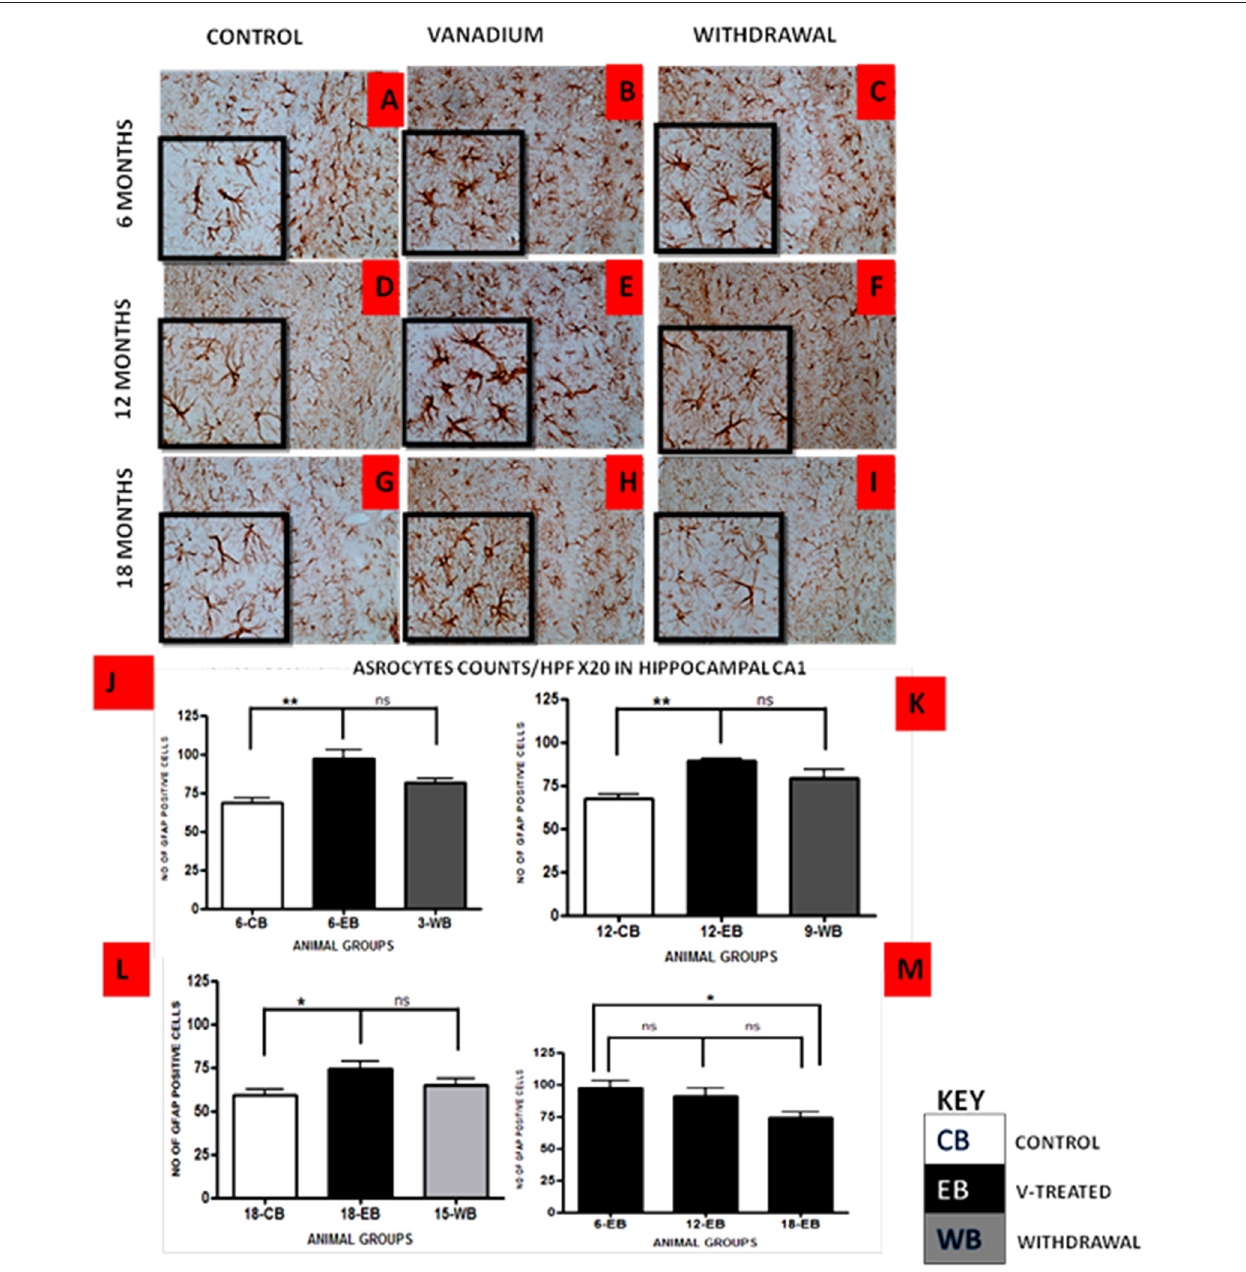
FIGURE 2 | GFAP-immunostained dorsal CA1 hippocampal region of vanadium exposed (B,E,H) , age matched control (A,D,G) and withdrawal group (C,F,I) mice. Vanadium treatments for 6, 12 and 18 months revealed Astrocytic activation identified by thickened cell body with more extended cytoplasmic processes relative to the matched controls while the withdrawal groups showed reversal effect relative to vanadium exposed groups. The number of GFAP positive cells were counted by two blinded investigators and average of N = 5 per group counts are shown per high powered field (HPF, 20 × ) in (D–F) respectively. The differences between groups (J–L) were evaluated for significance using analysis of variance (ANOVA; ∗ p < 0.05; ∗∗ p < 0.01). Astrocytic response decreases into old age with increasing vanadium exposure ( M ; 6EB vs. 18EB = ∗ p < 0.05). Magnification: × 200, inset: × 400.